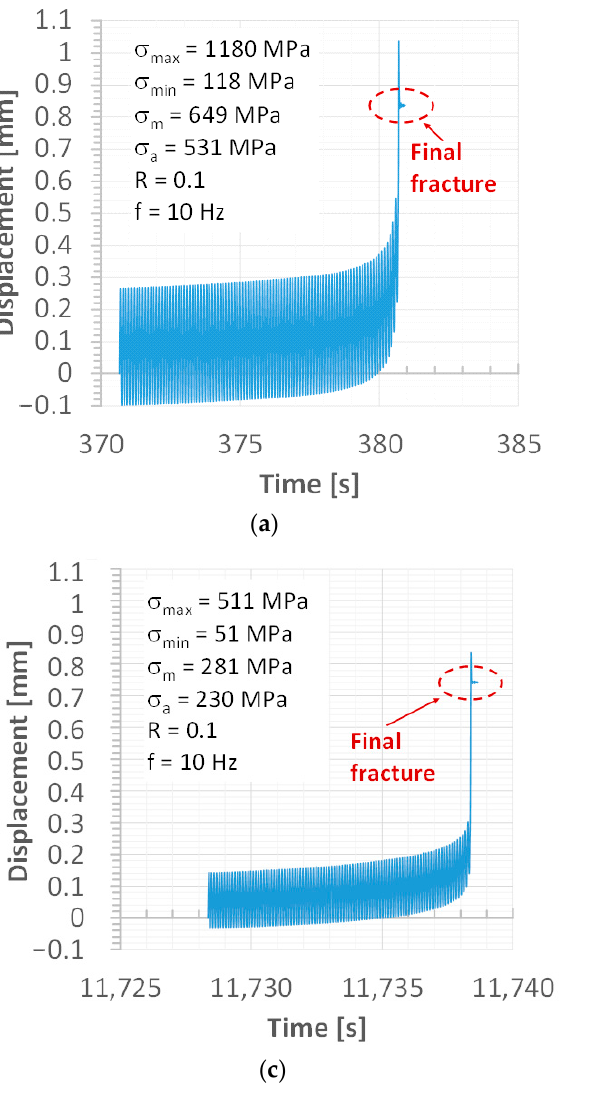
( c ) Figure 13. Variations of displacement ( a ), ( b ) its proportion versus the number of cycles and ( c ) maximum value of the stress.